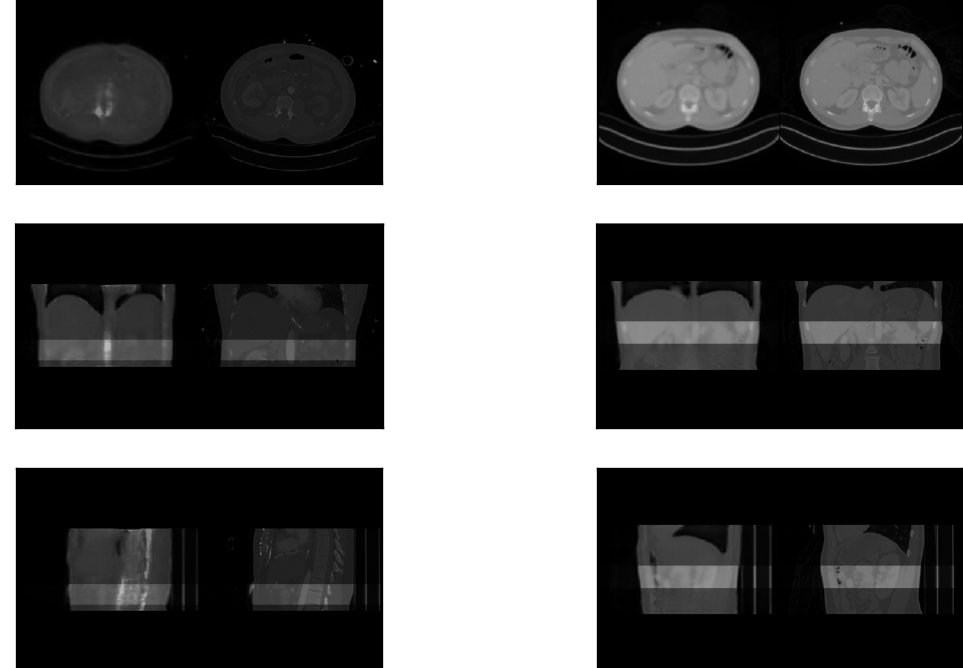
Figure A2. 3D extrapolation examples. Each example provides a comparison of the extrapolated image ( left ) with the ground truth image ( right ). Top —axial view; Middle —coronal frame (extrapo- lation axis); Bottom —sagittal